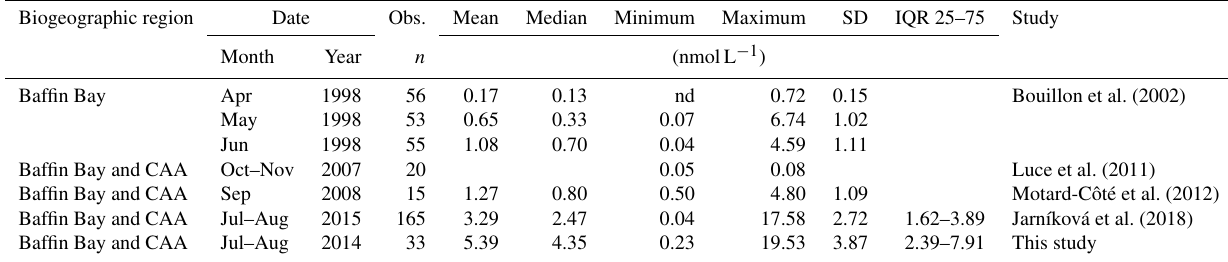
Table 3. Number of observations (Obs.), mean, median, minimum, maximum, standard deviation (SD), and interquartile range (IQR, 25th to 75th percentiles) of surface DMS concentrations from the Canadian Arctic Archipelago (CAA) and Baffin Bay biogeographic sectors from spring to autumn. DMS observations from this study include the transect stations (BS, LS, NS, and NOW) as well as other stations in the CAA and Baffin Bay sampled during the ArcticNet–NETCARE campaign (see Fig. 8 for DMS spatial distribution